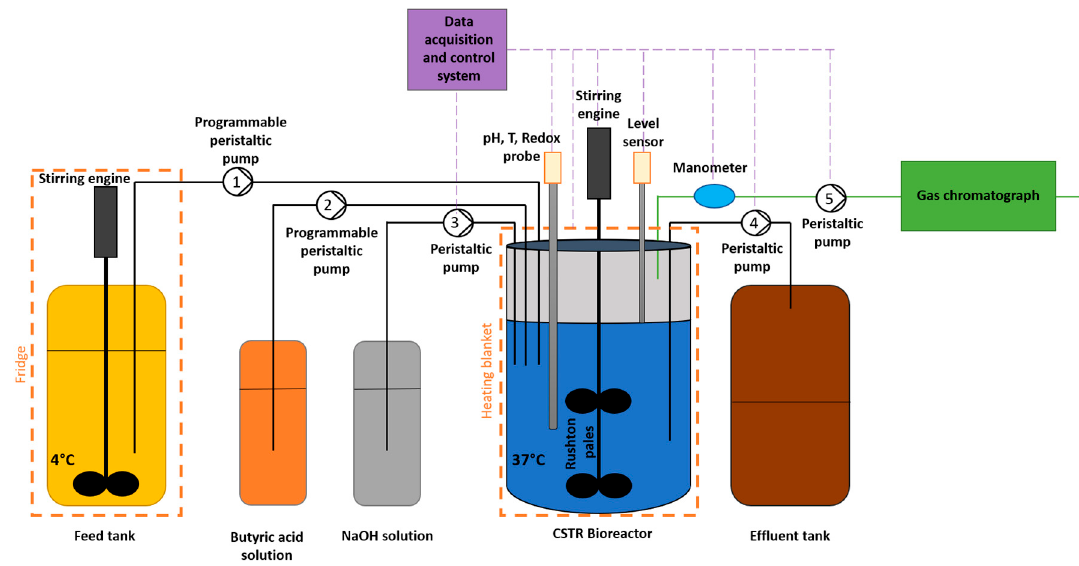
Figure 1. Schematic representation of the experimental setup used. 1, 2, 3, 4, 5: pumps for feed addition, butyric acid addition, pH regulation, effluent withdrawal, and pressure